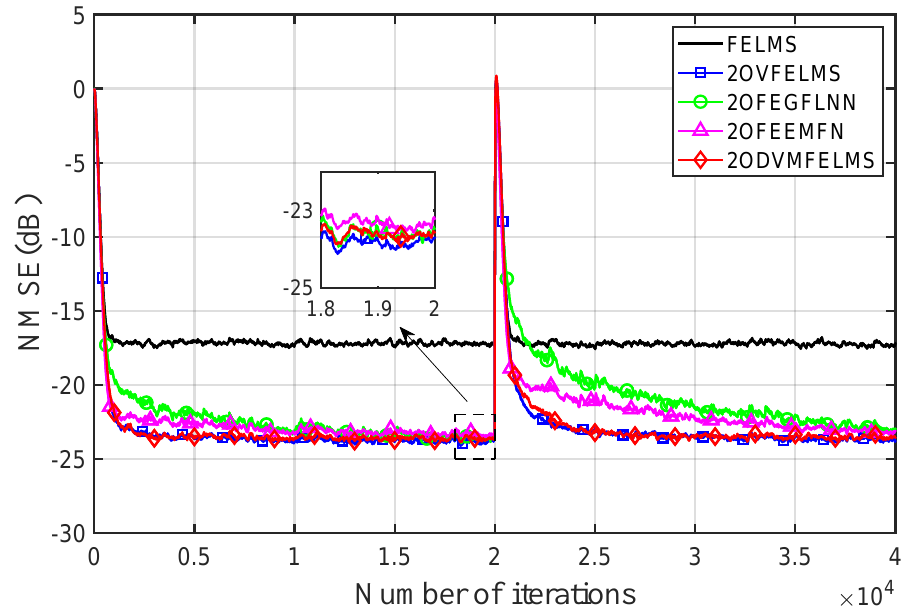
Figure 7. Performance comparison using the nonlinear primary path and secondary path with band-limited white Gaussian reference